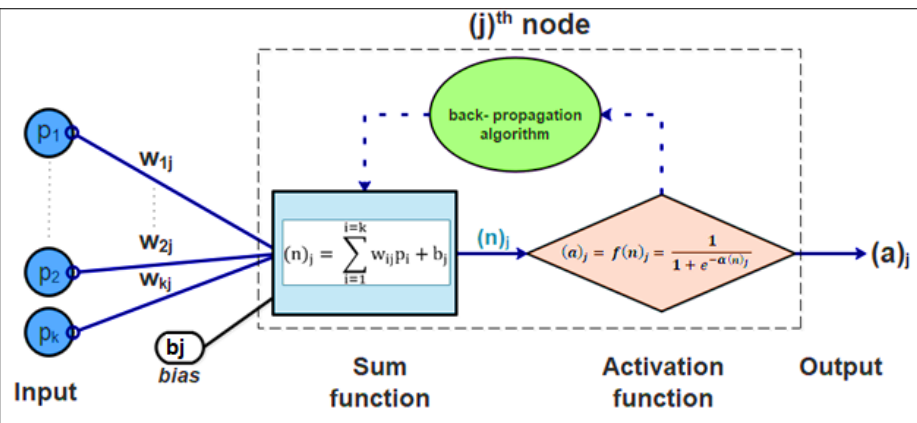
Figure 1. Architecture of artificial node and its interactions in the neural network.